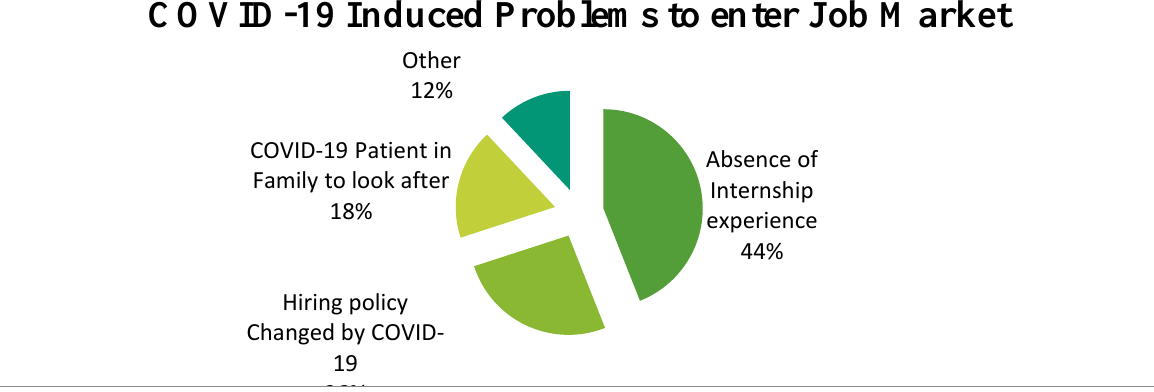
Figure 5 : Figure 5 shows that, among the problems induced by COVD-19 to enter the job market three problems are most prevalent. Among the respondents, 22 fresh graduates hold the absence of internship experience as a major challenge to enter the job market, the second major problem identified by 13 fresh gradates is the changed hiring policy of organization induced by COVID-19 which discourage to recruit fresh graduate, finally 9 students experienced the responsibility to look after COVID-19 relative fallen onto their shoulder. While only 6 students mentioned about other problems like low job posting, delayed recruitment process